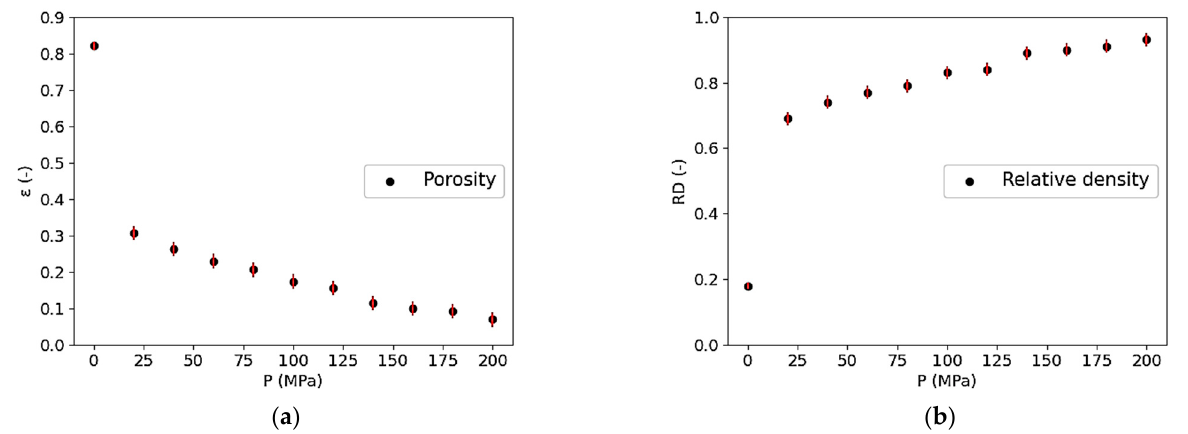
Figure 3. MCC PH101 tablet ( a ) average porosity and ( b ) relative density variation with the compression pressure.